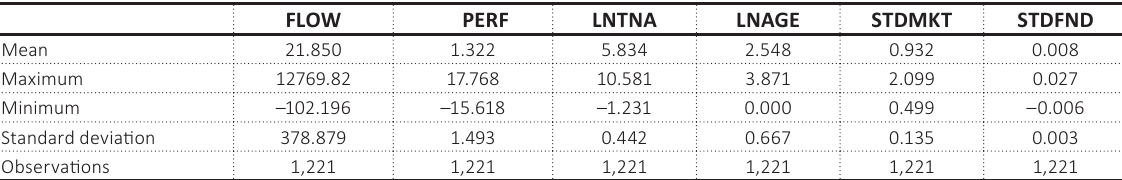
Table 1. Descriptive statistics